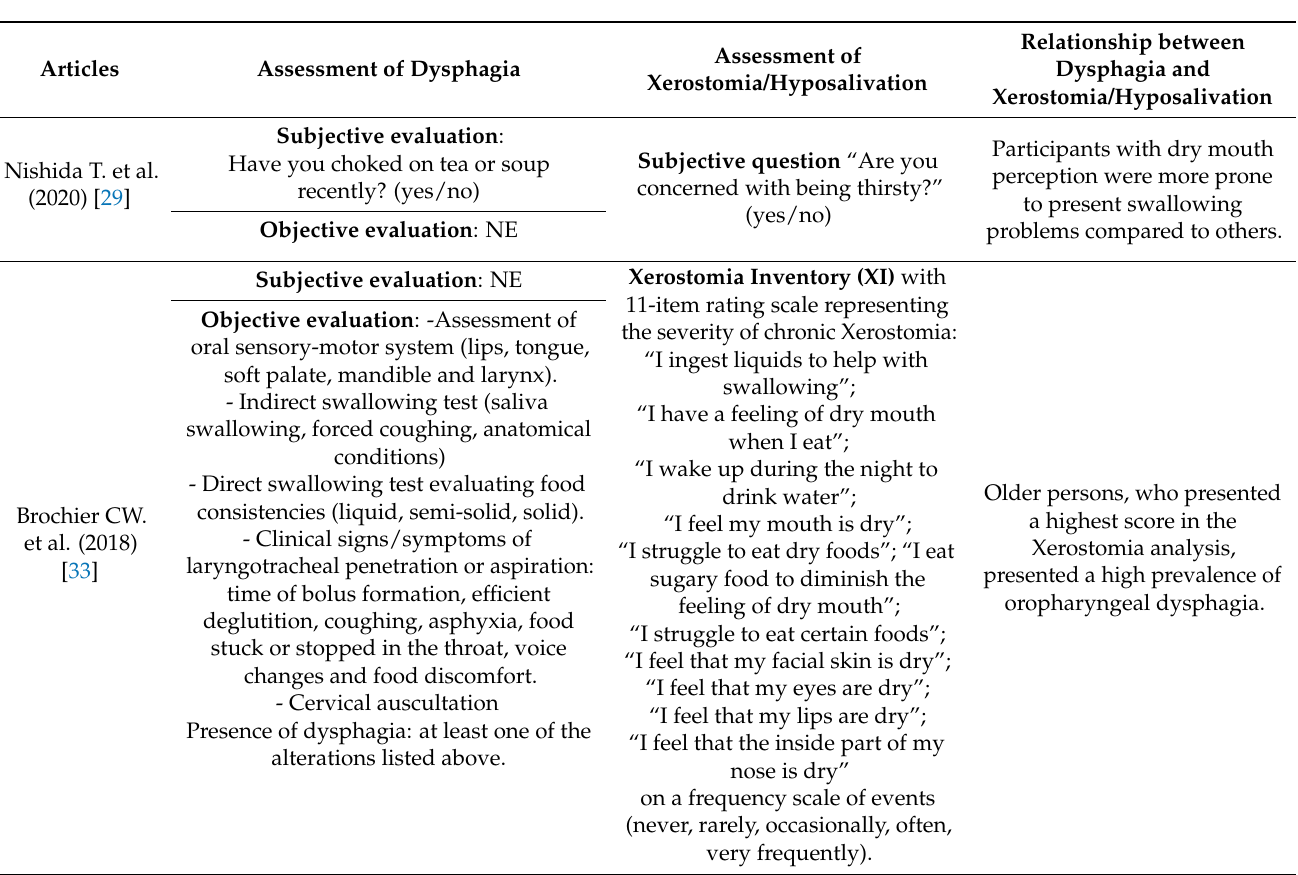
Table 3. Criteria used to establish a link between xerostomia/hyposalivation and